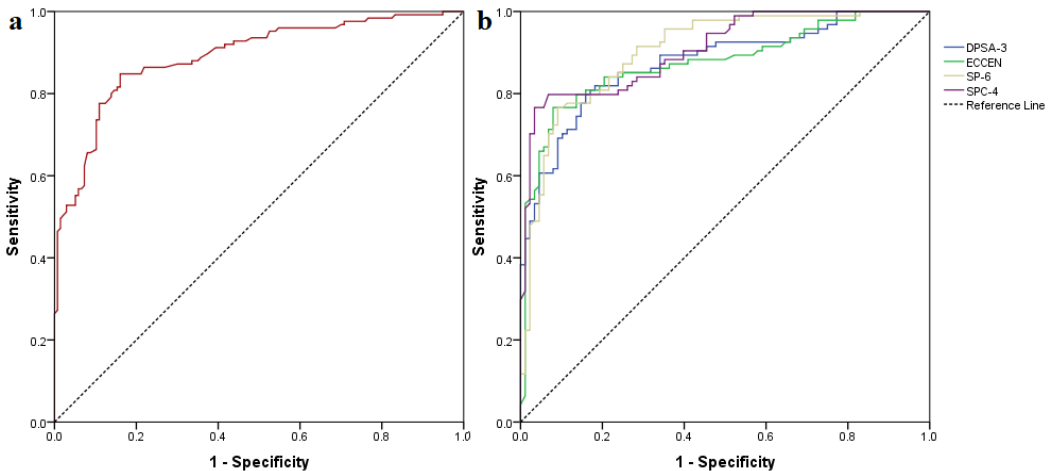
Figure 4. ( a ) global ROC curve of the generated classification model; ( b ) ROC curves of chosen classifiers for the training